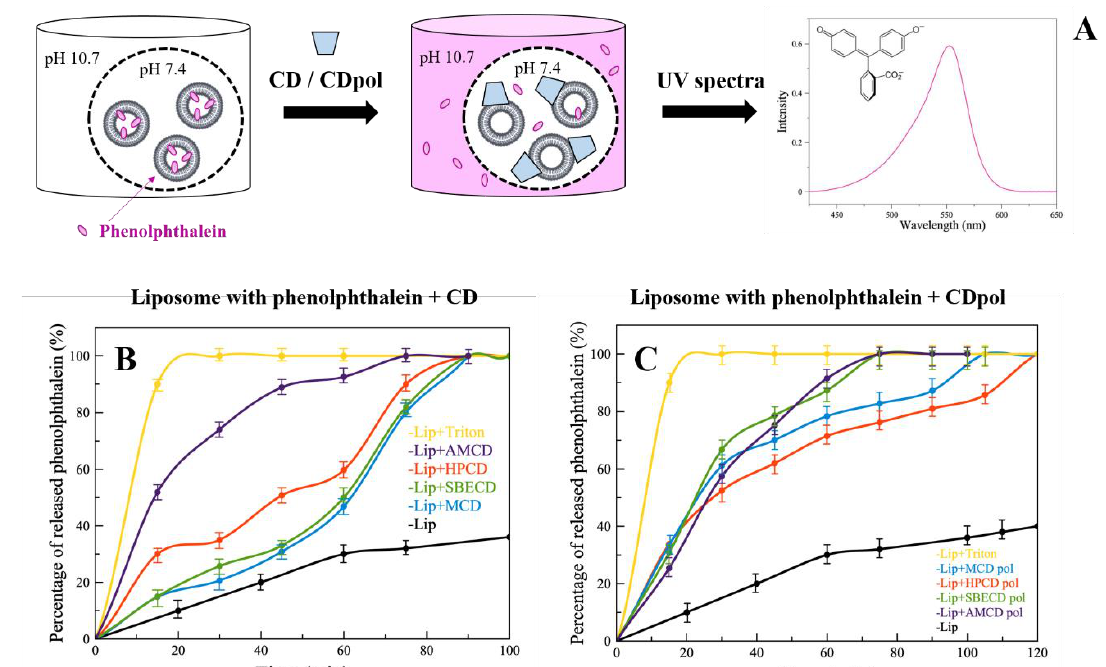
Figure 2. UV spectra of phenolphthalein ( A ), pH 10.7 (0.02 M Na-borate buffer solution), 22 °C . The release kinetics of PP from liposomes DPPC:CL = 80:20 (weight %) after adding CD ( B ) or CDpol ( C ), C CD torus = 30 mg/mL, pH 7.4 (0.02 M Na-phosphate buffer solution), pH 10.7 (0.02 M Na-borate buffer solution), 37 °C.